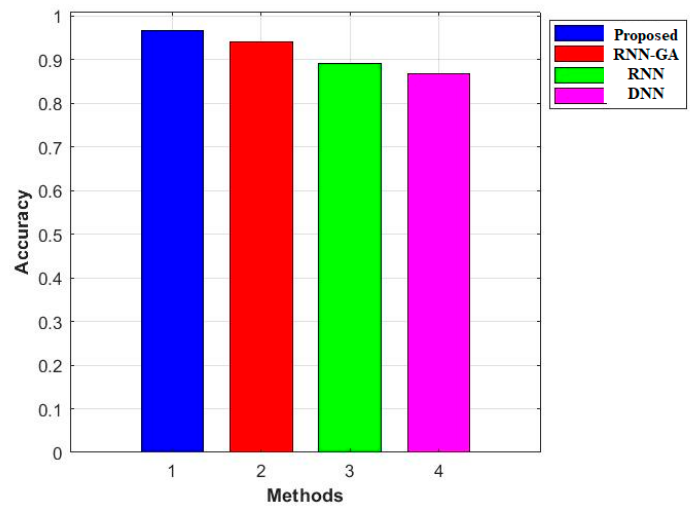
Figure 8. The Accuracy performance of confusion matrix.